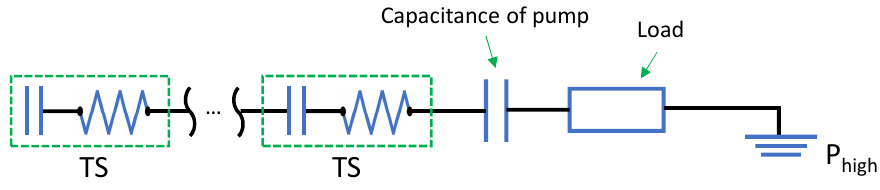
Figure 21: The hydraulic circuit connection representing the DC pressurization. Figure 21. The hydraulic circuit connection representing the DC